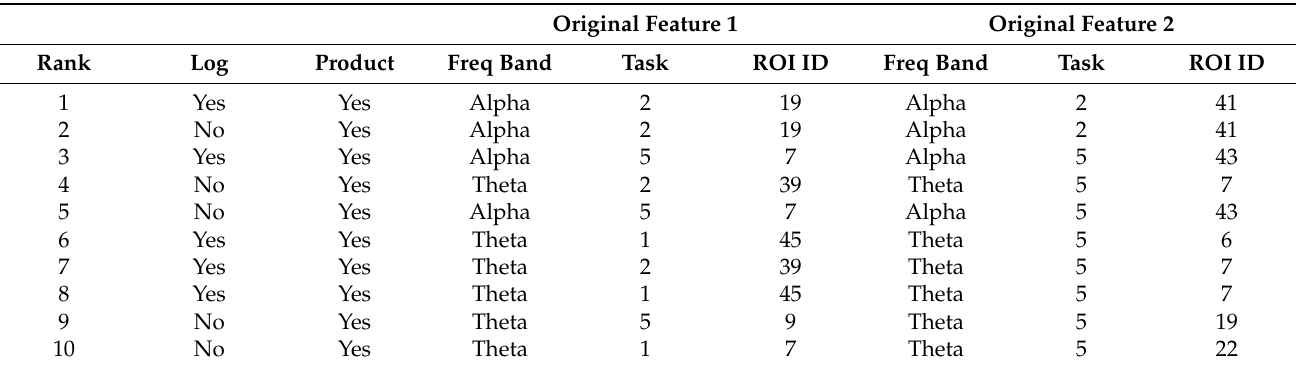
Table 1. Top 10 features with highest chi-square statistic for predicting anxiety. Augmented features consist of, at most, 2 original features and incur, at most, two transformations (product of pairs and log transform). This table shows details of top 10 features in terms of chi-square statistic.